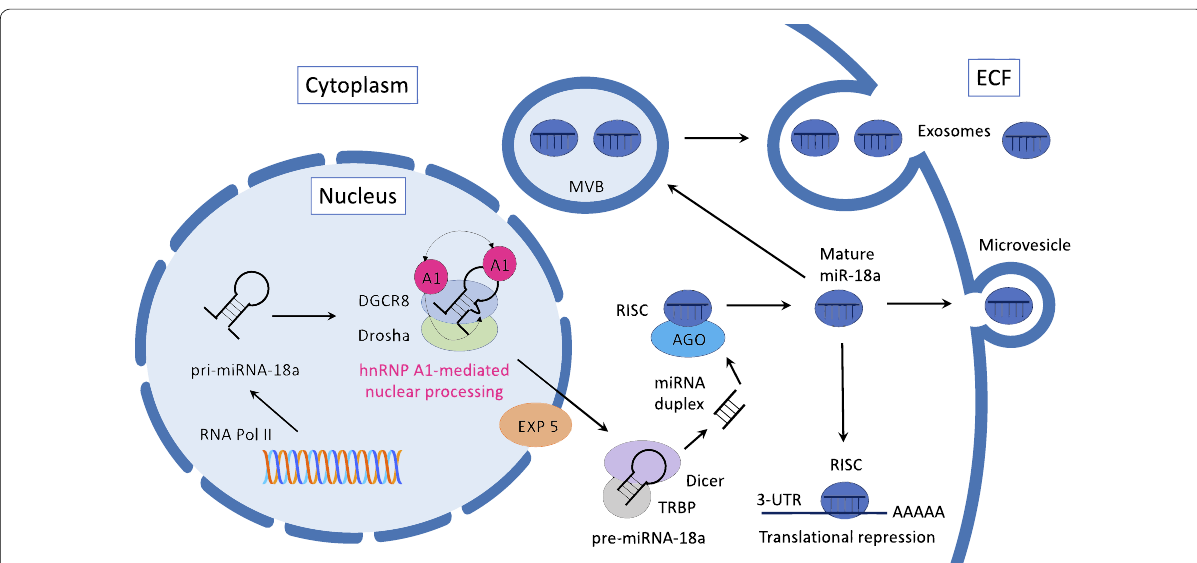
Fig. 2 The biogenesis of miR-18a. Model of miR-18a biogenesis, function and secretion. The miR-18a gene is transcribed into pri-miR-18a in the nucleus and is processed by the Microprocessor complex, which is composed of Drosha and DGCR8, to generate pre-miR-18a. Pre-miR-18a is then exported into the cytoplasm by exportin 5 (EXP 5) and cleaved by Dicer into a miRNA duplex. One strand of the duplex is selectively loaded into the RNA-induced silencing complex (RISC) along with argonaut (AGO). Mature miR-18a in the RISC complex can engage in base pairing with its target mRNA and induce translational repression or can be transferred into recipient cells directly by microvesicles or loaded into multivesicular bodies (MVBs) and exosomes, which are subsequently secreted into the extracellular